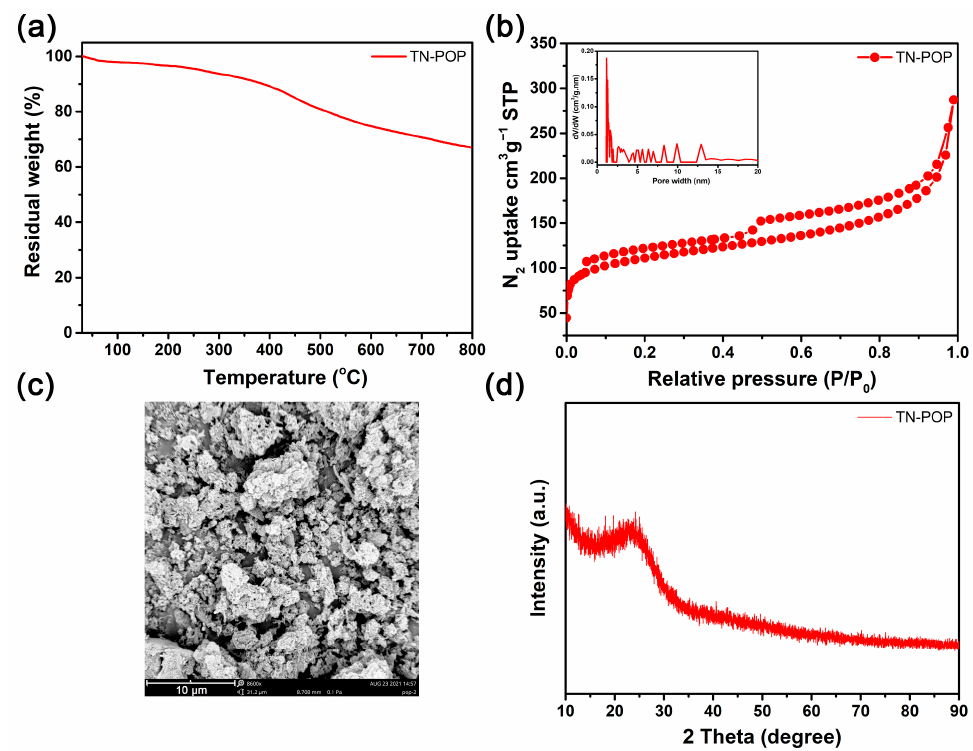
Figure 4. ( a ) TGA curve of TN-POP; ( b ) N 2 -physisorption isotherm and pore size distribution curve (inset) of TN-POP; ( c ) SEM image of TN-POP; ( d ) PXRD spectrum of TN-POP.